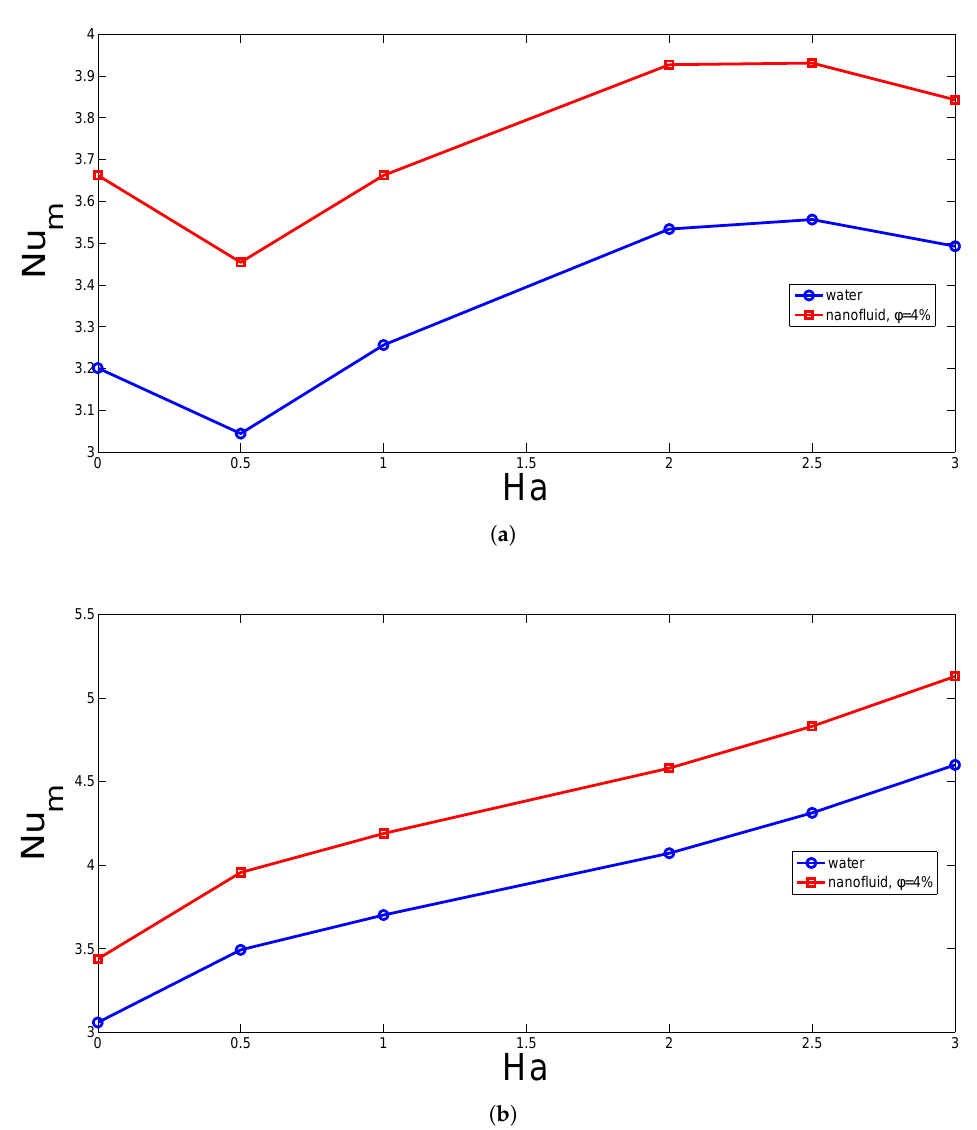
Figure 7. Average Nusselt number versus Hartmann number variations for the upper hot walls of the vertical and horizontal exit channels for water and nanofluid (Re = 300): ( a ) W2, average Nusselt number variation; and ( b ) W4, average Nusselt number